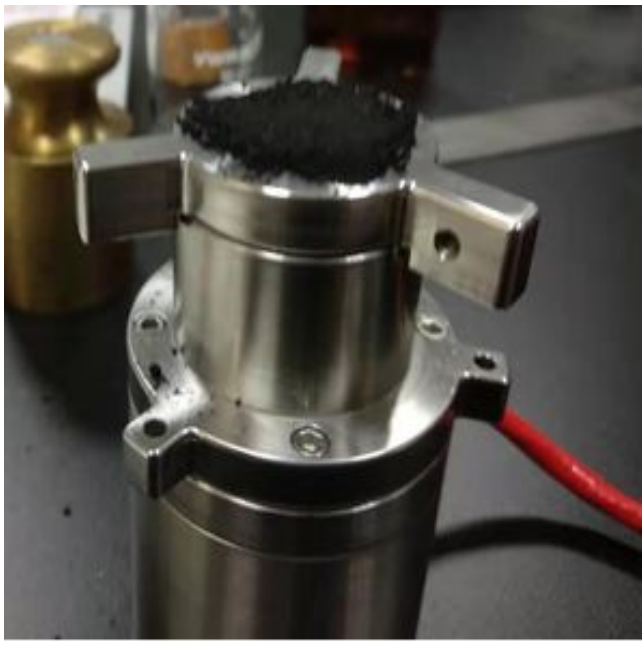
Figure 4. C-Therm conductivity meter.